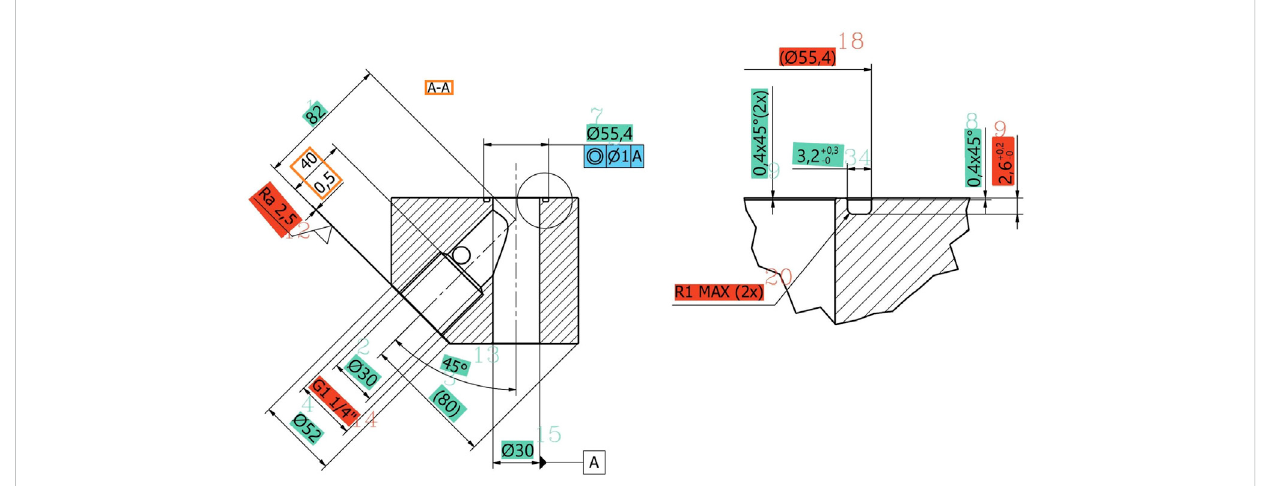
FIGURE 6 Results from the dimension pipeline. Masked image. Blue predictions are potentially correct predictions, red predictions are potentially missing one or more characters, orange outlines are predictions discarded.